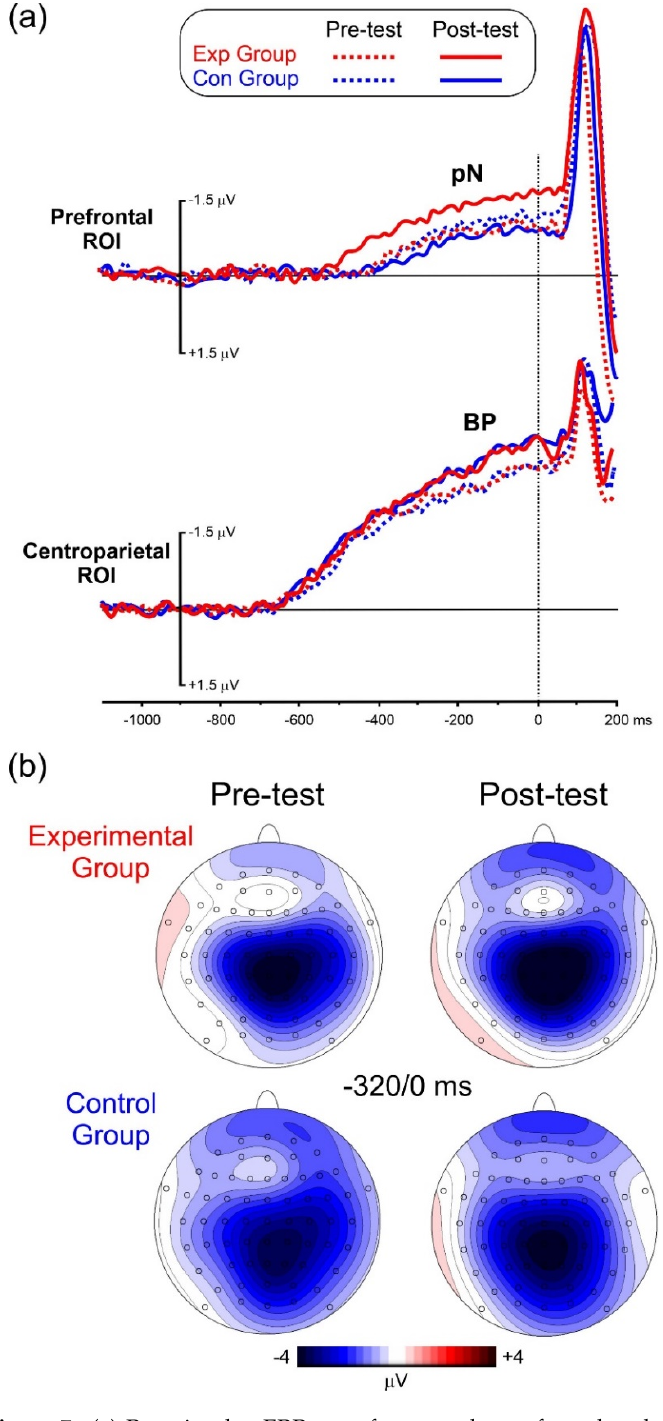
Figure 7. ( a ) Pre-stimulus ERP waveforms at the prefrontal and centroparietal ROIs. ( b ) Scalp topography in the − 320/0 ms time window.